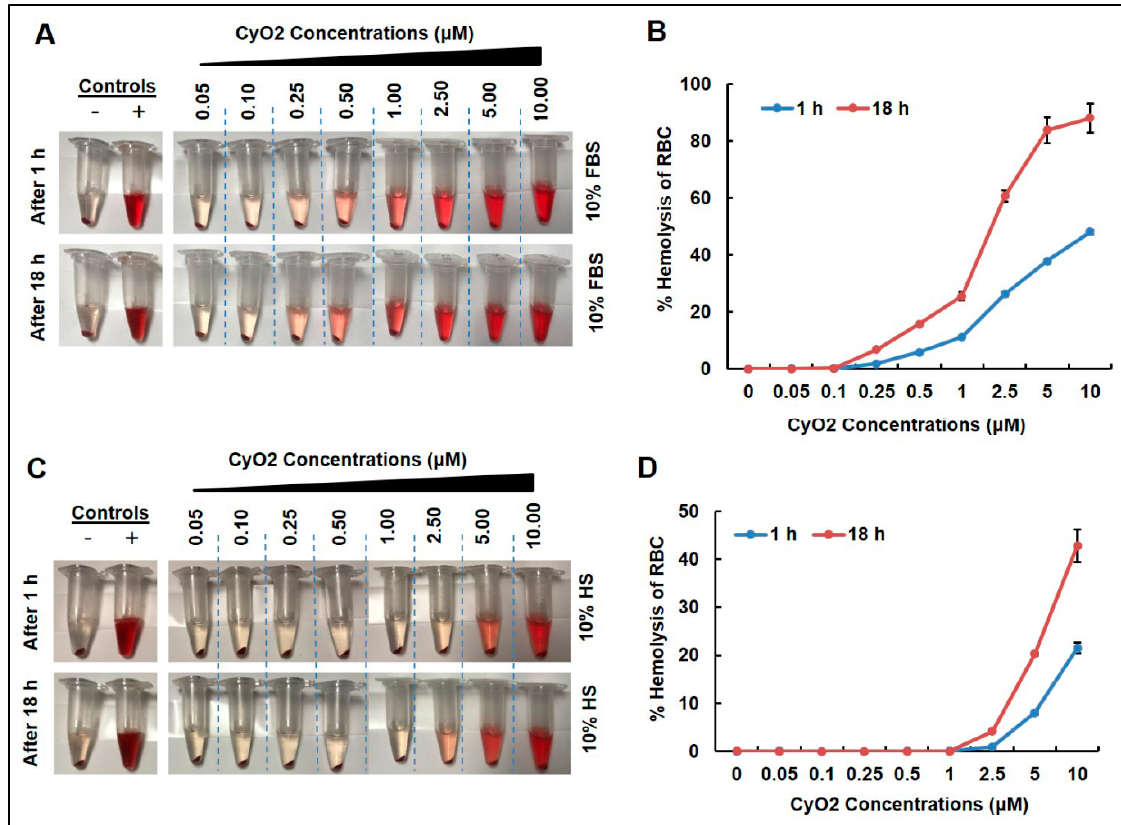
Figure 2. Time and dose-dependent effects of CyO2. CyO2 demonstrated dose-dependent hemolytic activity in red blood cells incubated for 1 and 18 h, in the presence of either fetal bovine serum (FBS) ( A , B ) or human serum (HS) ( C , D ). Error bars show +/- standard error of means (SEM).